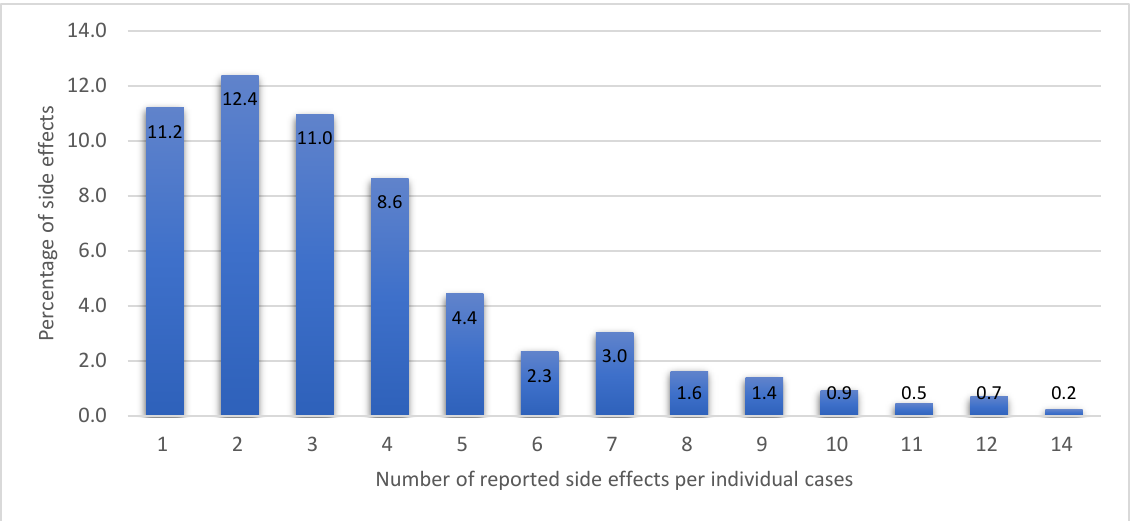
Figure 3. Percentages of the number of reported side effects of the COVID-19 vaccination.